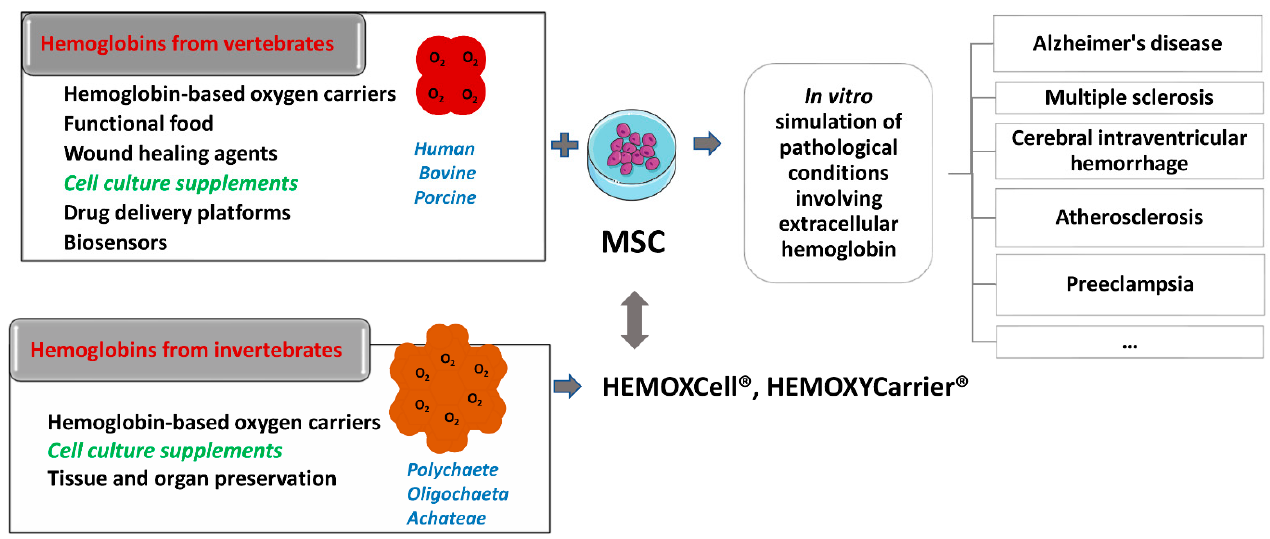
Figure 2. Schematic presentation of the potential use of vertebrates and invertebrates’ hemoglobin preparations in biomedicine and biotechnology (left side of the scheme), emphasizing already commercially available cell culture additives based on invertebrate hemoglobin (HEMOXCell ® , HEMOXYCarriers ® , HEMARINA SA, Morlaix, France). Up-to-date research on the impact of such hemoglobin preparation on mesenchymal stromal cell (MSC) cultures could significantly contribute to a better understanding of the onset and progression of pathological conditions involving extracellular hemoglobin as presented on the right side of the scheme.